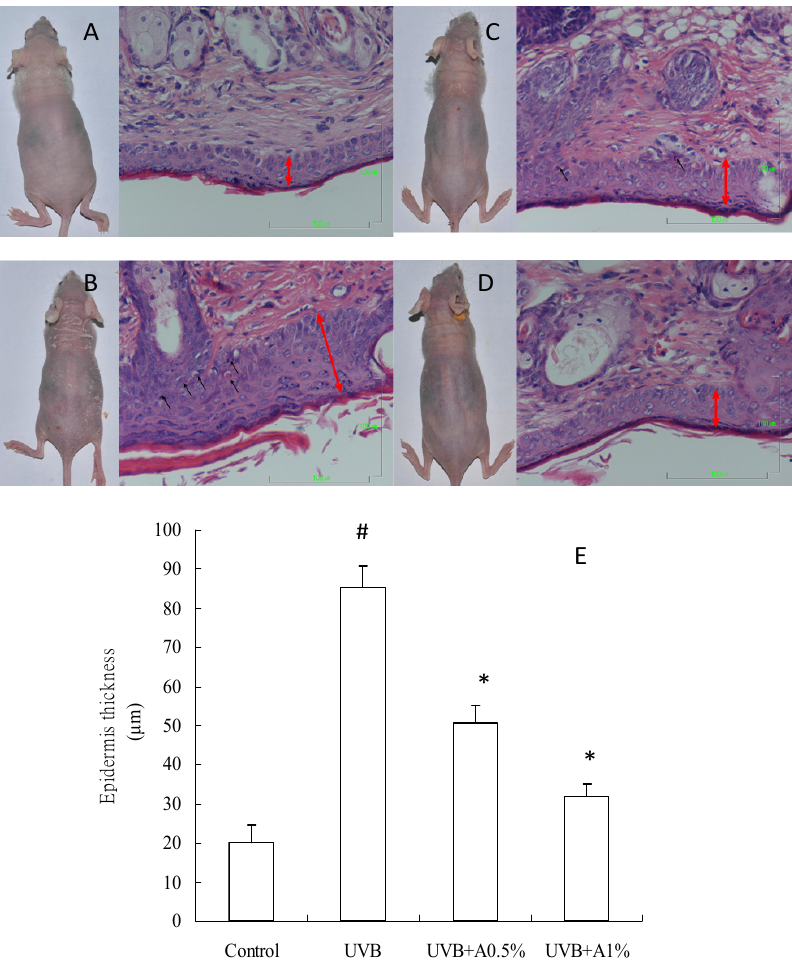
Figure 2. Artocarpus communis methanol extract attenuated skin scaling, epidermis thickness and the formation of sunburn cells in UVB-irradiated hairless mice. ( A ) control; ( B ) UVB irradiation; ( C ) pretreatment with ACM 0.5% after UVB irradiation; ( D ) pretreatment with ACM 1% after UVB irradiation; ( E ) the result of epidermis thickness on different groups is represented by the mean ± SD ( n = 4). Statistical significance was defined as p <